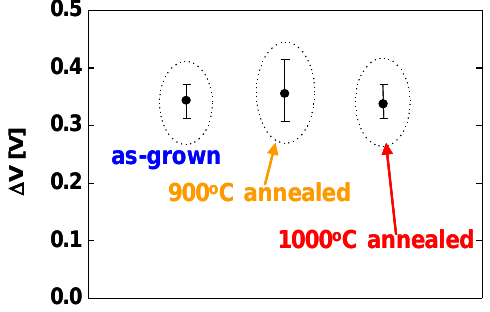
Figure 2. The sensitivity of Pt–(Si-doped) GaN Shottky diodes for 1% H temperature as a function of the annealing temperature of the GaN surfaces. The sensitivity is defined as a shift of voltage upon exposure to 1% H current of 0.1